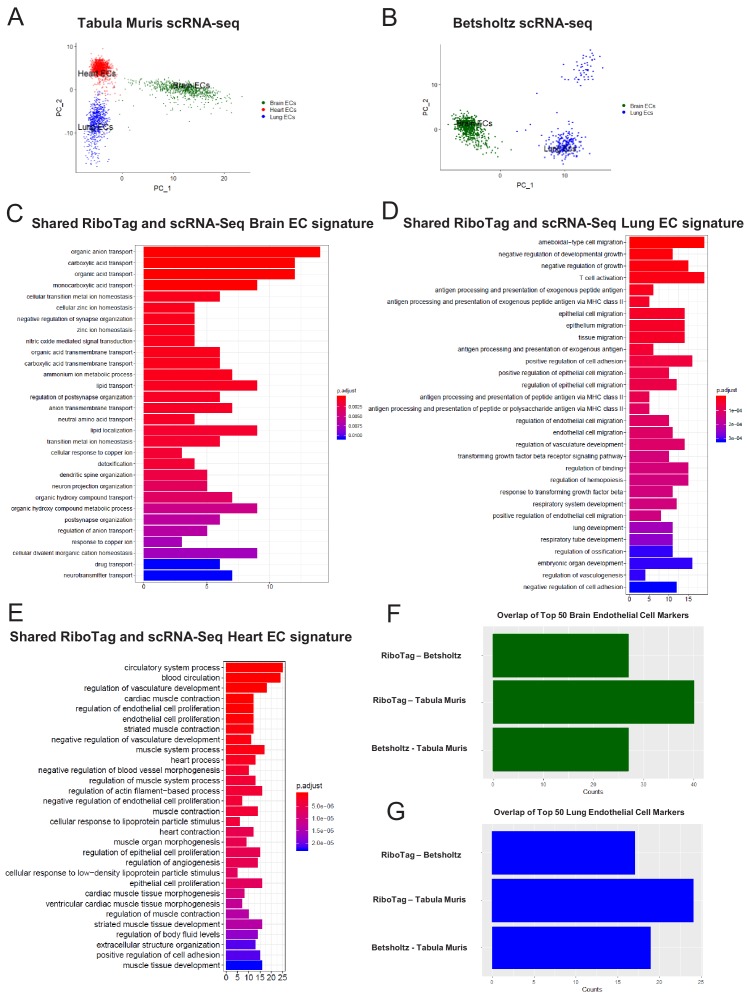
Single-cell endothelial heterogeneity (A) PCA of endothelial scRNA-Seq data from the Tabula Muris collection of mouse tissues colored by tissue.(B) PCA of endothelial scRNA-Seq data from the Betsholtz Lab of mouse tissues colored by tissue. The GSEA results of enriched GO terms from overlapping differentially expressed genes between RiboTag and Betsholtz or Tabula Muris for (C) brain ECs, (D) lung ECs, and (E) heart ECs. (F) Overlap of top 50 scRNA-Seq brain EC marker genes with RiboTag brain EC marker genes. (G) Overlap of top 50 scRNA-Seq lung EC marker genes with RiboTag lung EC marker genes.